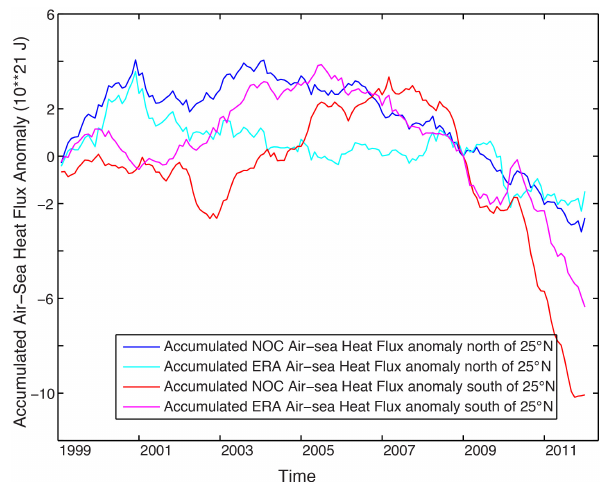
Figure 6. Accumulated anomalous air–sea heat flux versus 1999– 2008 average for the NOC air–sea and ERA-Interim heat flux clima- tologies. North of 25 ◦ N represents the area 25–45 ◦ N, 60–20 ◦ W; south of 25 ◦ N represents the area 10–25 ◦ N, 60–20 ◦ W. Normal air–sea heat flux is defined as the averaged flux for each month over the 10-year period January 1999 to December 2008. The anomaly air–sea flux is then the difference between the monthly flux and the normal monthly flux. Anomaly heat fluxes are then accumulated over time from January